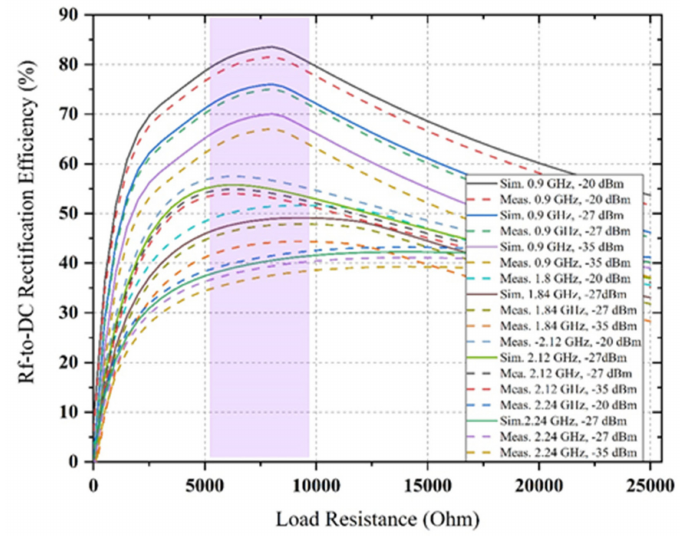
Figure 18. The comparison (between simulated and measured) of RF-to-DC rectification efficiency of the rectifier circuit as a function of load resistance for different frequencies with associated RF power